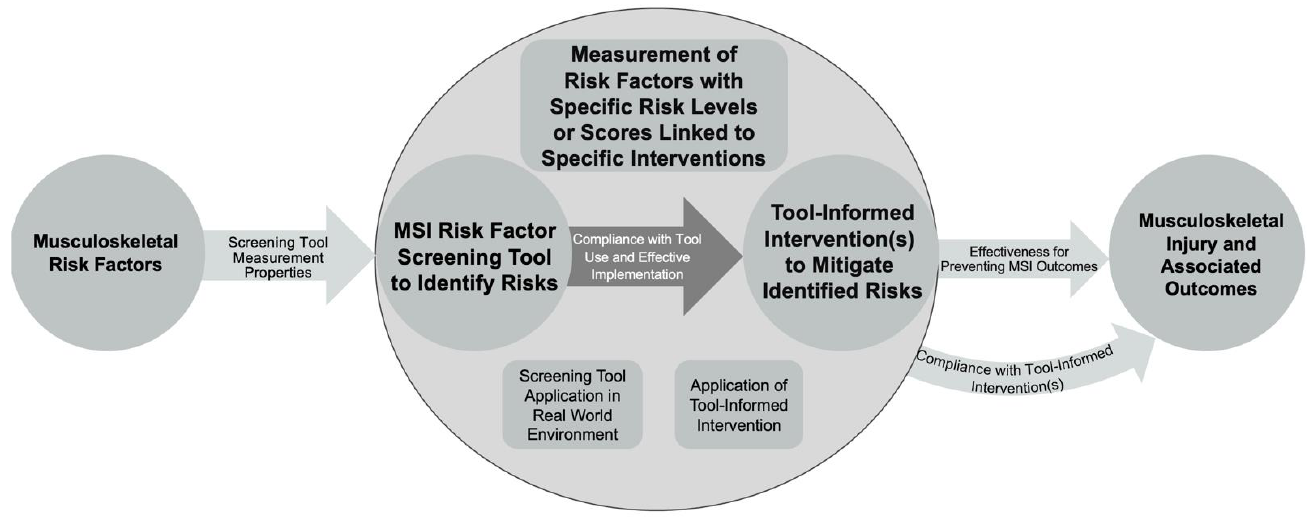
Figure 1. Logic map showing how musculoskeletal injury (MSI) risk factor screening tools inform interventions to affect MSI-associated outcomes. 147